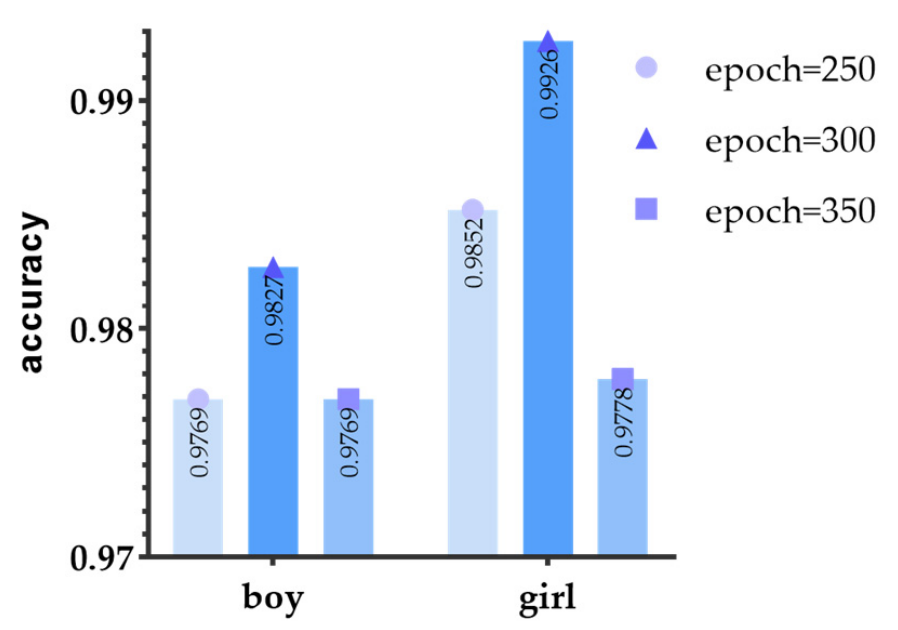
Figure 6. Different accuracies for different epochs. The dark blue column with a triangle performs the best.